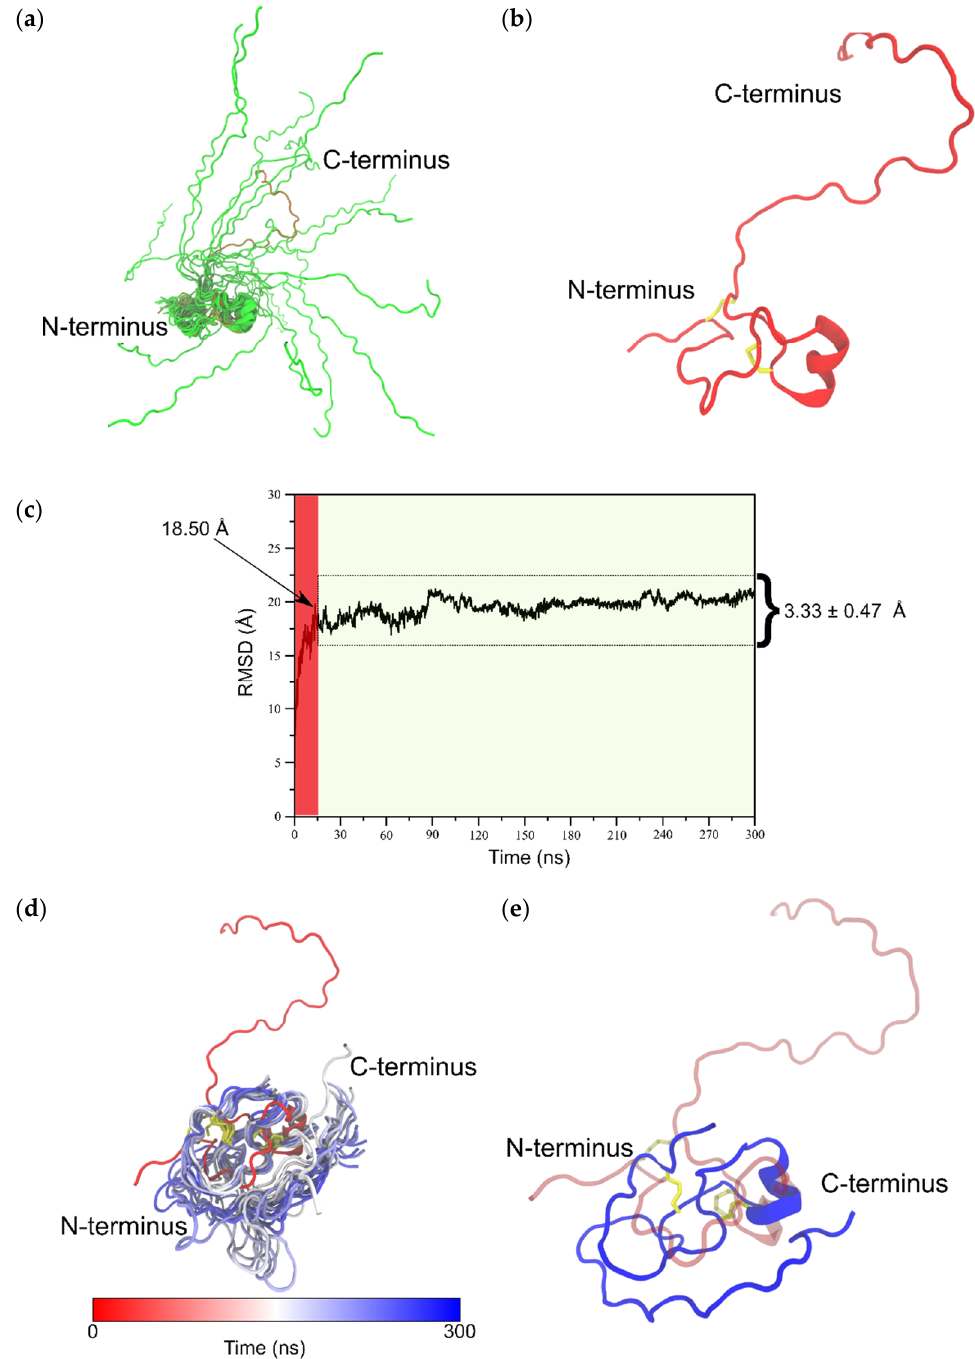
Figure 4: ( a ) Figure depicts 20 structures (green cartoons) from the 100-member NMR ensemble of full-length isomer B [C19S,C25S] [29] aligned on the N-terminal residues (1–37). The lowest energy model 1 is shown as red cartoons. ( b ) The lowest energy model from the NMR ensemble of isomer B [C19S,C25S] [29] used as input in the 300 ns molecular dynamics (MD) simulation. ( c ) Backbone root mean square deviation (RMSD) trace from the 300 ns MD simulation of isomer B [C19S,C25S] [29] with respect to its starting structure. The initial 15 ns of this simulation is considered as the equilibration phase (shaded red) and the remainder of the simulation (shaded green) is considered the production phase of the simulation. ( d ) Figure presents 20 equidistant structures from between 150 and 300 ns of the simulation as an ensemble (white to blue gradient cartoons) with the starting structure (red cartoon) shown as an indicator of the extent of structural change especially at the C-terminal (residues 38–66). ( e ) The final snapshot of the 300 ns MD simulation (blue cartoon) shown along with the starting structure (red transparent cartoon).